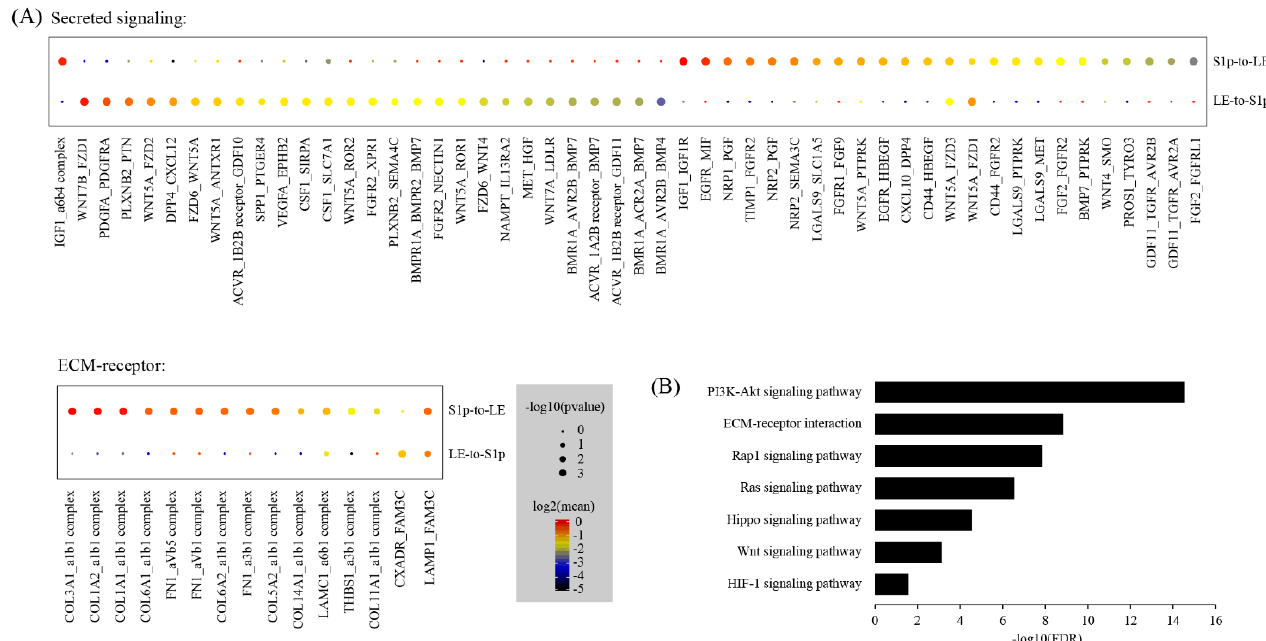
8 of 13 Figure 7. Pseudotime ordering of stromal cells: ( A – C ) The distribution of pseudotime ( A ), cell origin ( B ) and cell type ( C ) across the reconstructed trajectory. The numbers inside the black circles represent the different cell status numbers iden-